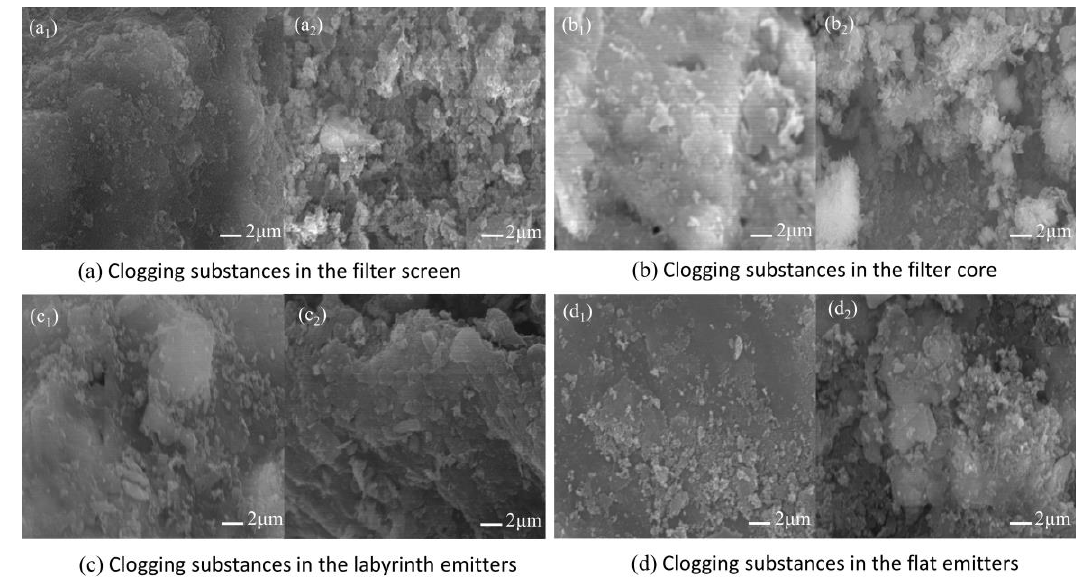
Figure 4. Scanning electron microscope images of clogging substances.